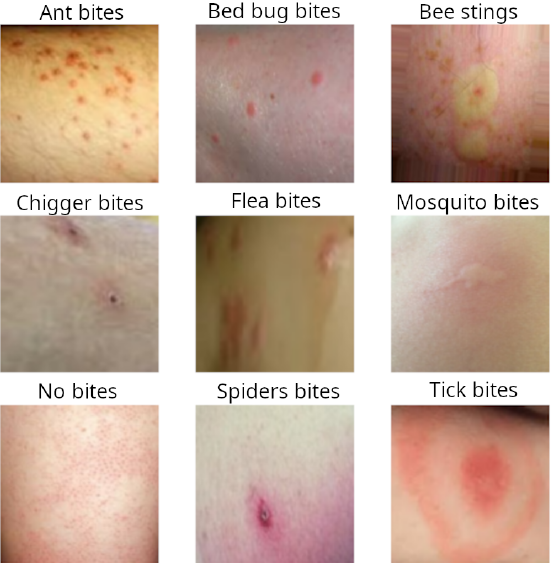
Figure 2. Sample images from each class in the final dataset for bug bite